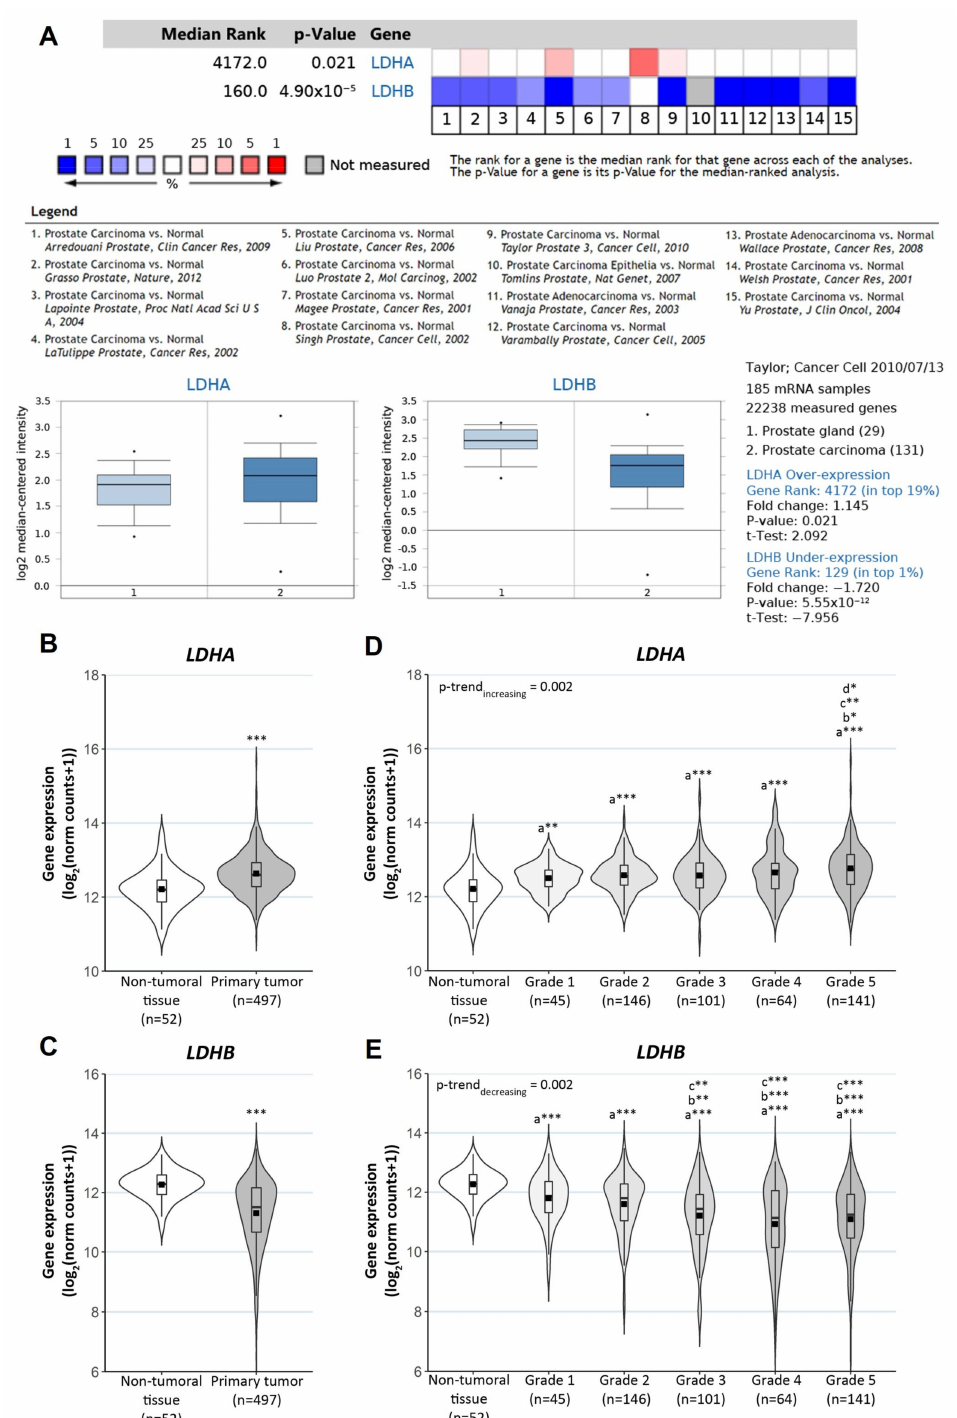
Figure 5. Clinical relevance of LDHA and LDHB expression in PCa. ( A ) Meta-analysis of microarray datasets on the public cancer database Oncomine for LDHA and LDHB expression ( n = 973 patient samples). One representative box plot is shown for each gene comparing its expression profile between group 1: Prostate Gland and group 2: Prostate Adenocarcinoma. Analysis of differential gene expression using RNAseq data from TCGA-PRAD: ( B ) LDHA and ( C ) LDHB mRNA levels in primary tumor samples ( n = 497) and non-tumoral adjacent tissue samples ( n = 52). ( D ) LDHA and ( E ) LDHB expression levels in PCa samples categorized according to the ISUP grading system. Significant differences: * p < 0.05; ** p < 0.01; *** p < 0.001; the letter represents which group sample was considered as a reference: a = non-tumoral tissue, b = grade 1, c = grade 2 and d = grade 3; p -trend values correspond to Jonckheere-Terpstra trend